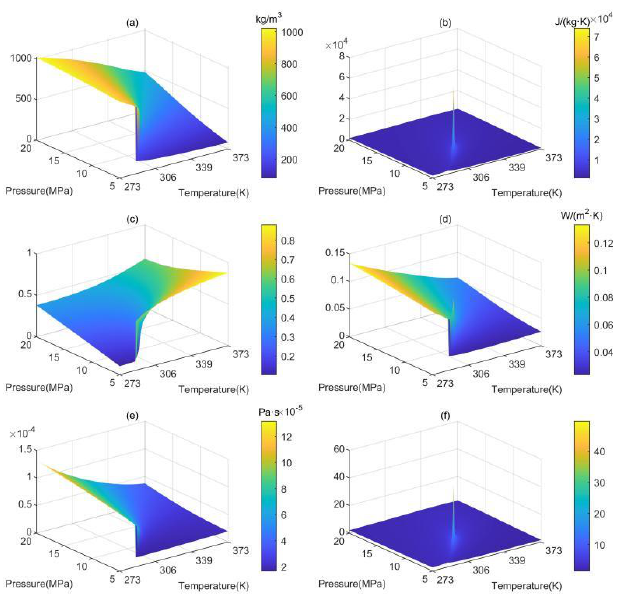
Figure 6. Physical property parameters of carbon dioxide: ( a ) density, kg/m 3 ; ( b ) isobaric heat capacity, J/(kg · K); ( c ) compressibility factor (Z); ( d ) thermal conductivity, W/(m · K); ( e ) viscosity, Pa · s; ( f ) specific heat capacity, J/(kg · K).